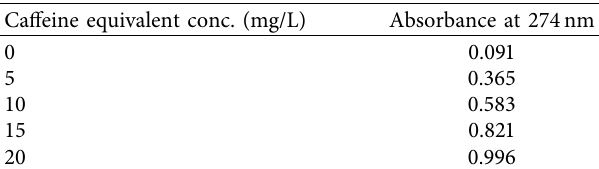
Table 2: Absorption of fnal solutions at 274nm.